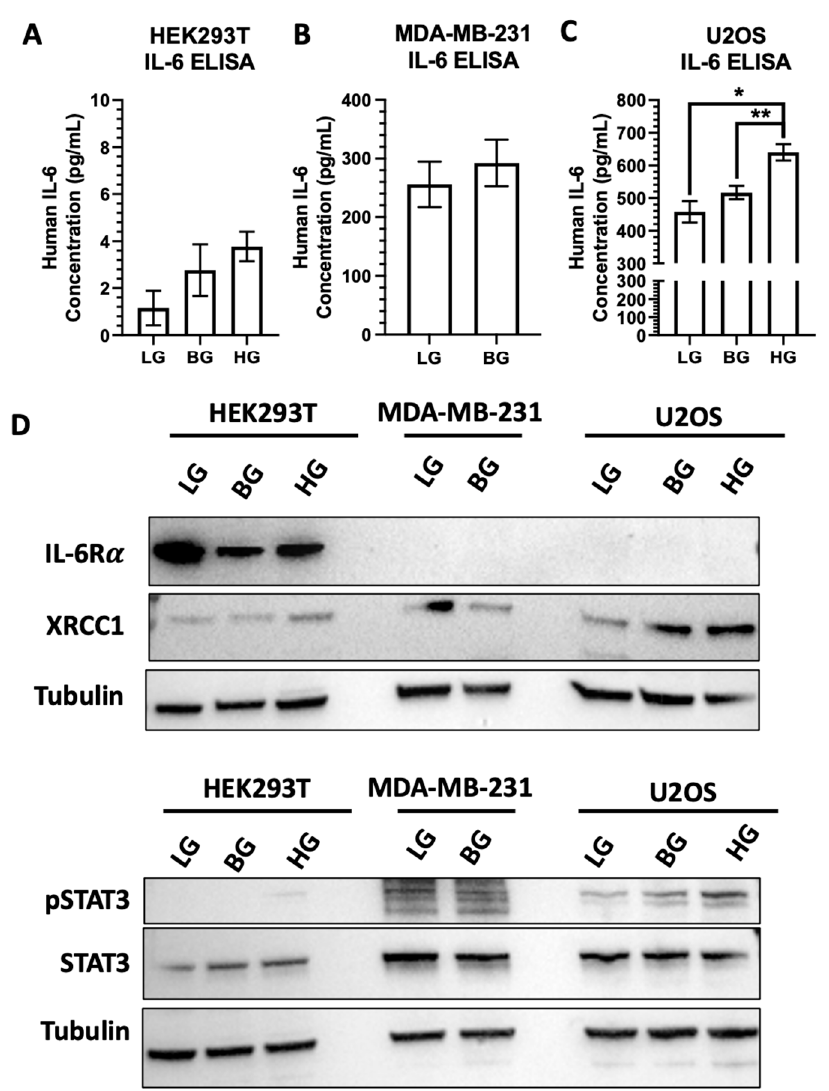
Figure 8. IL-6 secretion and IL-6R α expression modulated STAT3 activation and XRCC1 expression. IL-6 concentration in the spent media of glucose-adapted HEK293T ( A ), MDA-MB-231 ( B ), and U2OS ( C ) cell lines. Representative immunoblot ( D ) of pSTAT3, STAT3, IL-6R α , and XRCC1 in HEK293T-, MDA-MB-231-, and U2OS-adapted cell lines. * p < 0.05, ** p < 0.01.